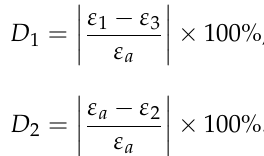
Figure 4. Strain gauge distributions of the epoxy resin matrix.